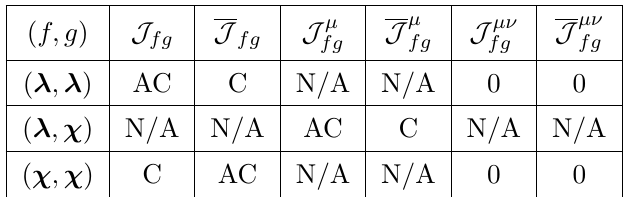
Table 4 . Summary of chiral/antichiral properties of all currents defined in eq. (6.1). C = Chiral, AC = Anti-Chiral, N/A = neither chiral or anti-chiral, 0 = this current is identically